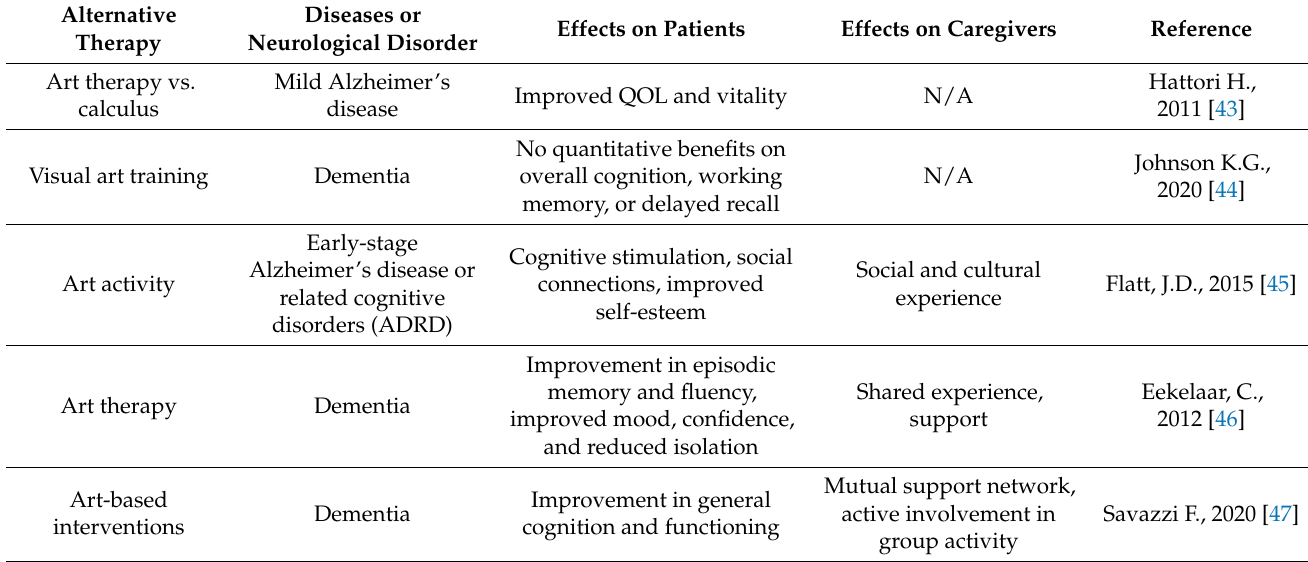
Table 3. Relevant studies for art